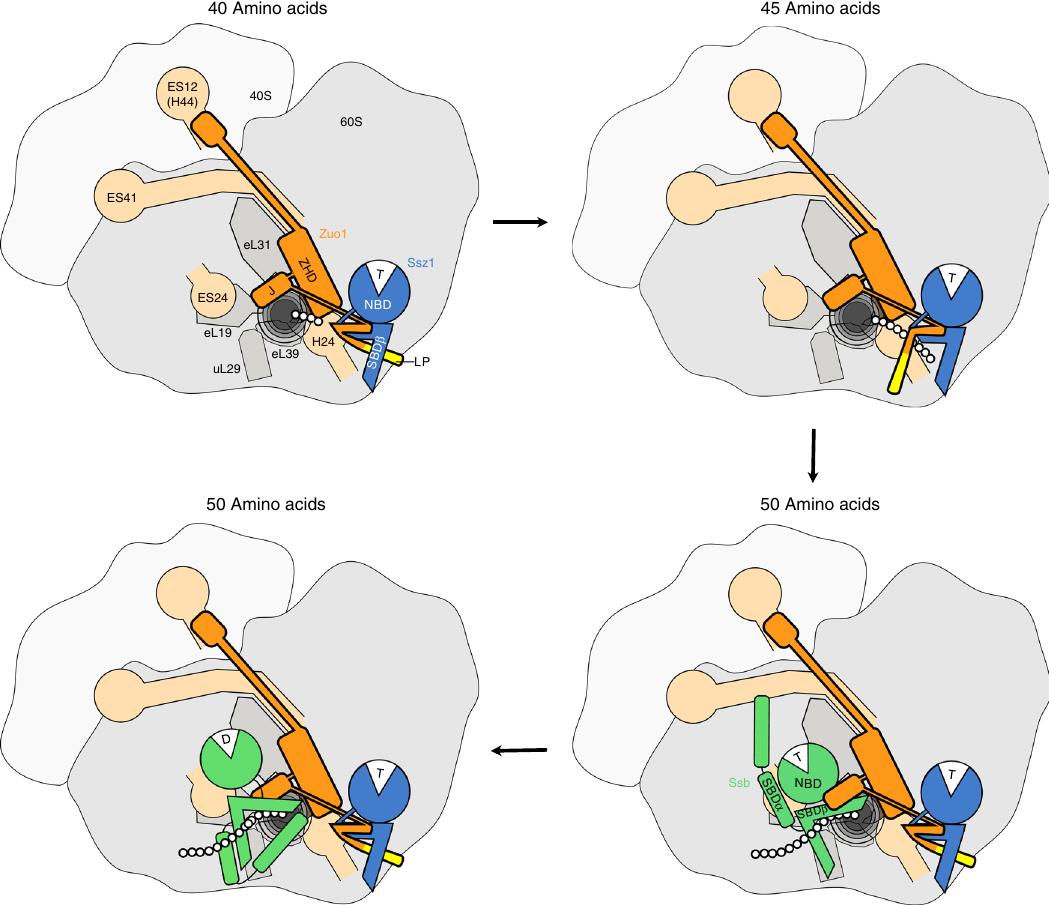
Fig. 4 Nascent chain handover at the ribosomal tunnel exit. Model of the RAC/Ssb substrate relay system at the ribosomal tunnel exit. At a length of 40 residues the nascent chain contacts Zuo1 (upper left panel). At a length of 45 residues the nascent chain reaches Ssz1 (upper right panel). This requires the displacement of the Zuo1 LP-motif from the Ssz1-SBD β . At 50 residues length, the nascent chain is transferred to Ssb, in a process that requires a direct transfer from the Ssz1-SBD β to Ssb-SBD β , and a contact of the Zuo1 J-domain with the linker region of Ssb (lower right panel). The latter stimulates ATP hydrolysis by Ssb and traps the nascent chain in a Ssb ⋅ ADP ⋅ nascent chain complex (lower left panel). Likely in this situation the LP-motif interacts with the Ssz1-SBD β . The ribosomal 60S and 40S subunits are shown in dark and light gray. The tunnel exit is indicated in black, and residues of nascent Pgk1 are represented as white circles. Zuo1 (orange), Ssz1 (blue), Ssb (green), and Zuo1 LP-motif (yellow). J-domain (J), Zuotin homology domain (ZHD), nucleotide binding domain (NBD), substrate binding domain (SBD). Main contacts of RAC and Ssb with ribosomal proteins (gray) and RNA (sand) are indicated (for details on the ribosomal contacts of RAC and Ssb see 4 ). For more details compare